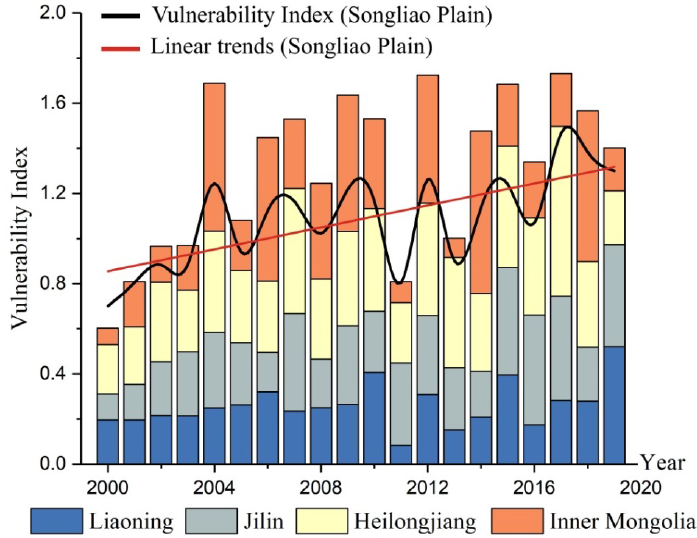
Figure 4. Change trend of drought vulnerability index of maize in Songliao Plain from 2000 to 2019.